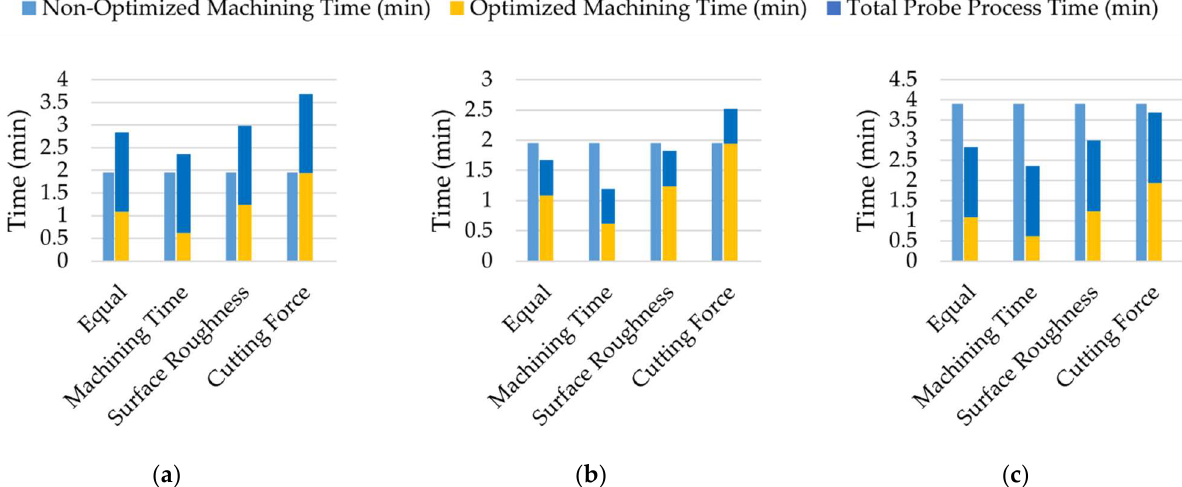
Figure 7. Process time breakdown for: ( a ) 3 beads and 1 facing pass; ( b ) 1 bead and 1 facing pass; ( c ) 3 beads and 2 facing passes.